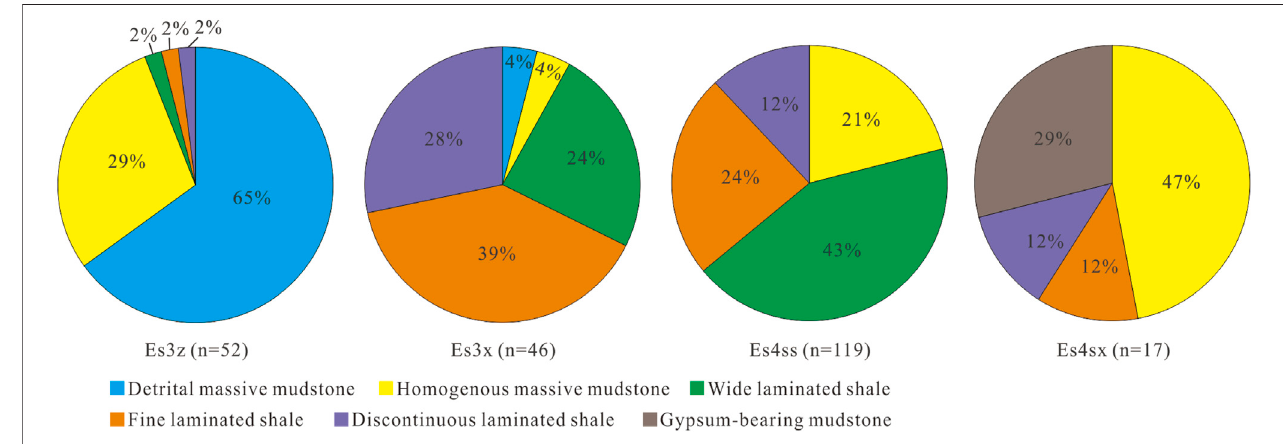
FIGURE 13 | Lithofacies proportion of shales in different members. The data compile from Zeng et al., 2017.